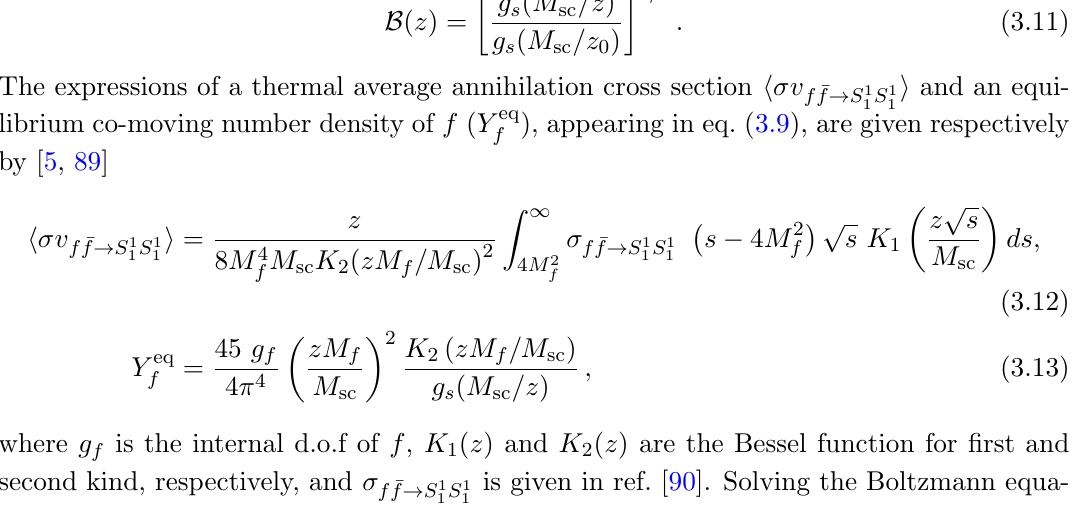
= 1 TeV, and (cid:11) = 0 : 01 rad. 2